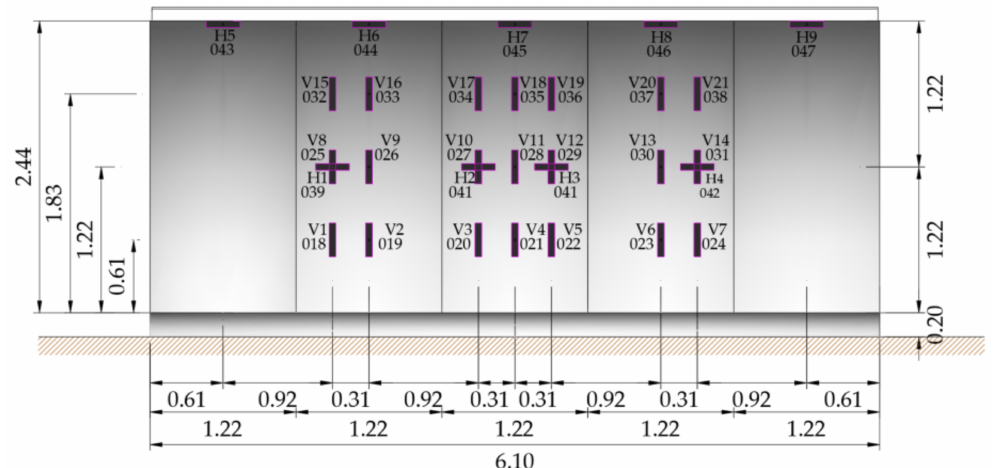
Figure 10. Strain Gauges identification on Wall 1 (east face).